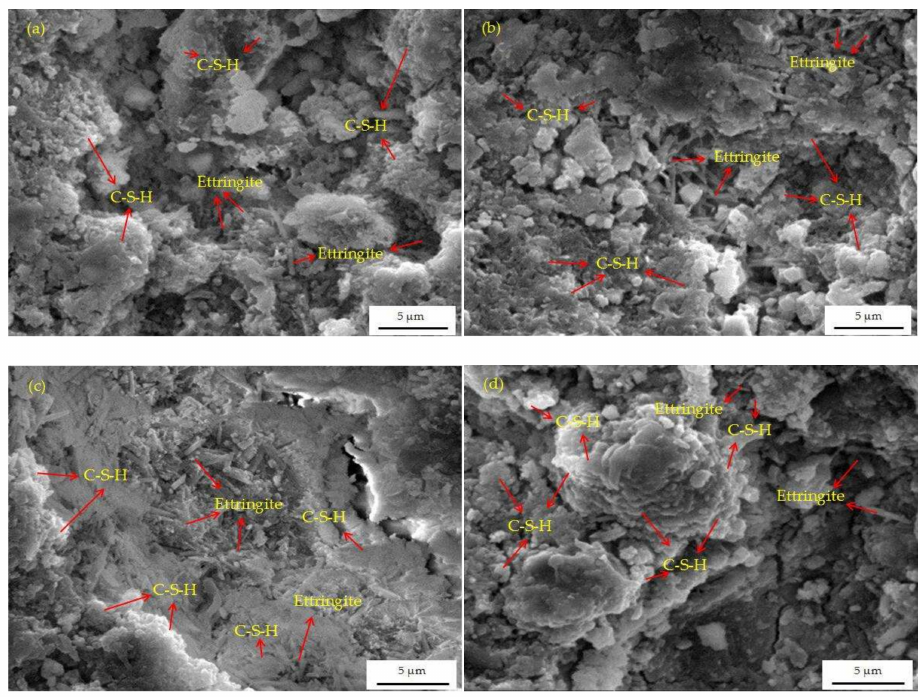
Figure 13. The SEM micrograph of paste samples with different LCFS content at 28 days: ( a ) LCFS-0; ( b ) LCFS-10; ( c ) LCFS-20; ( d )